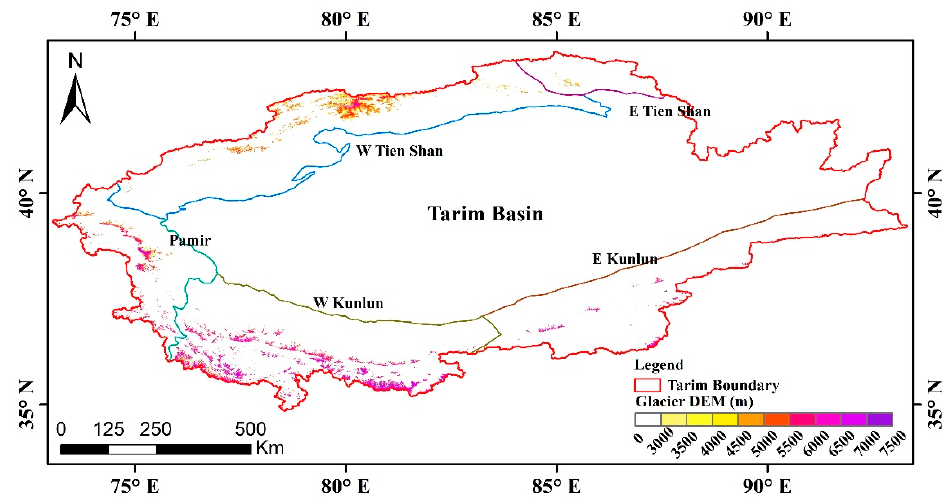
Figure 6. Location map and elevation of glacier area; the Digital Elevation Model is the Shuttle Radar Topography Mission (SRTM) DEM at 30 m resolution (Section 3.1.5).